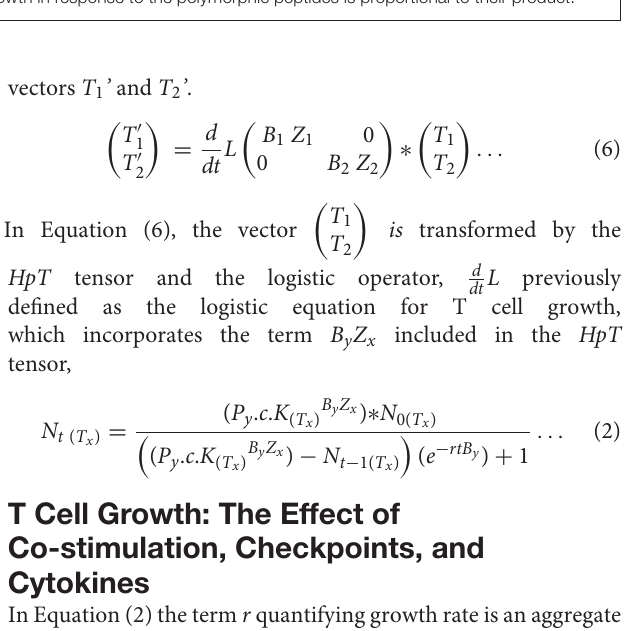
FIGURE 6 | Tensor diagram for the HpT tensor. Peptide p 1 binds different HLA molecules, (A–C) with affinities, B 1 , B 2 and B 3 (A) , while each TCR (TCR 1 − 3 ) binds these HLA-peptide complexes (with peptide, p 1 ), with affinities Z 1 , Z 2 , and Z 3 (B) . The vectors p1 indicate the average effect of multiple binding affinity vectors. These affinities will remain unaffected in different tissues and individuals. (C) T cell clonal growth in response to the polymorphic peptides is proportional to their